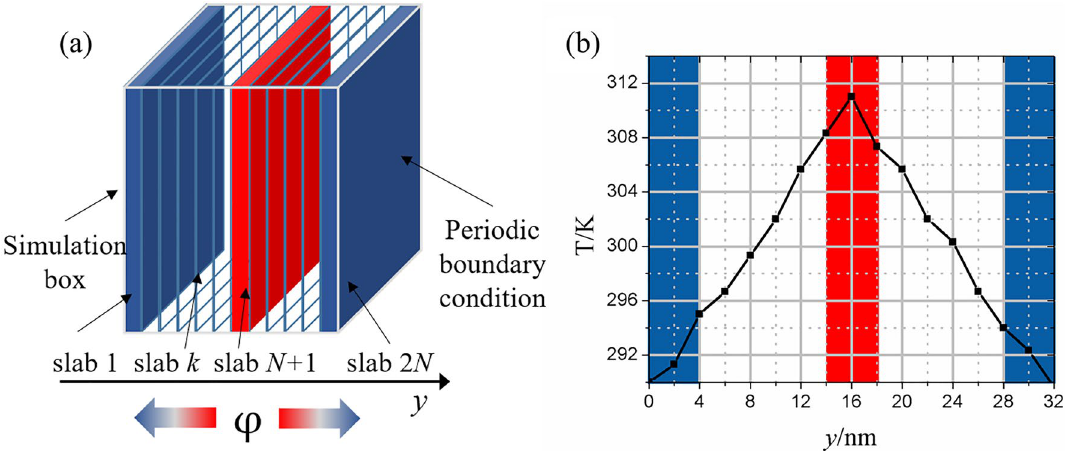
Figure 3. ( a ) A schematic drawing of reverse non-equilibrium MD, and ( b ) the temperature gradient profile along the heat transfer direction.